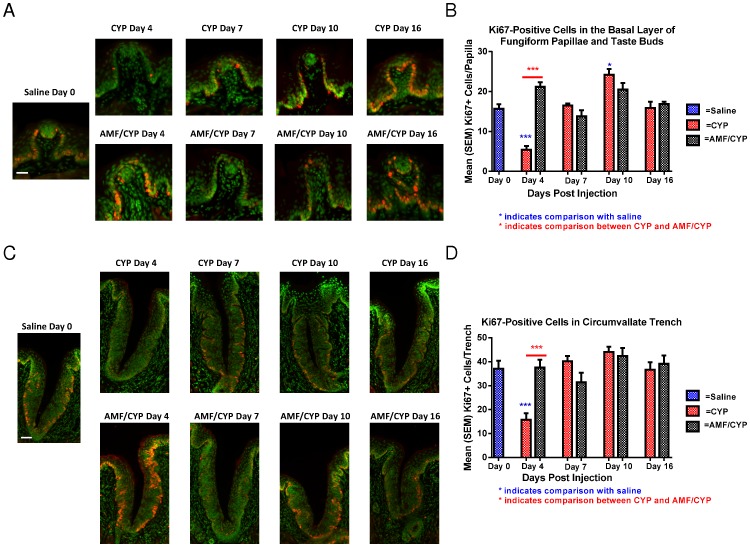
Ki67-positive cells.